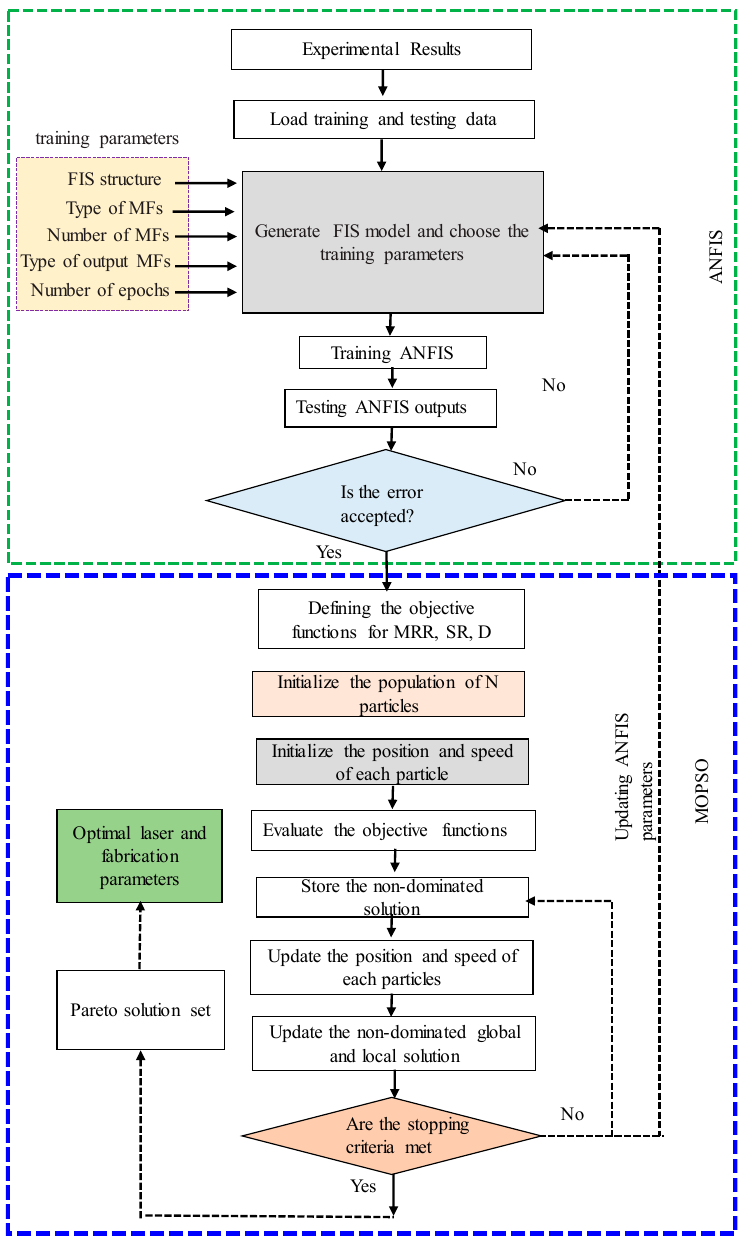
Figure 5. Structure of the integrated intelligent ANFIS–MPOSO method.